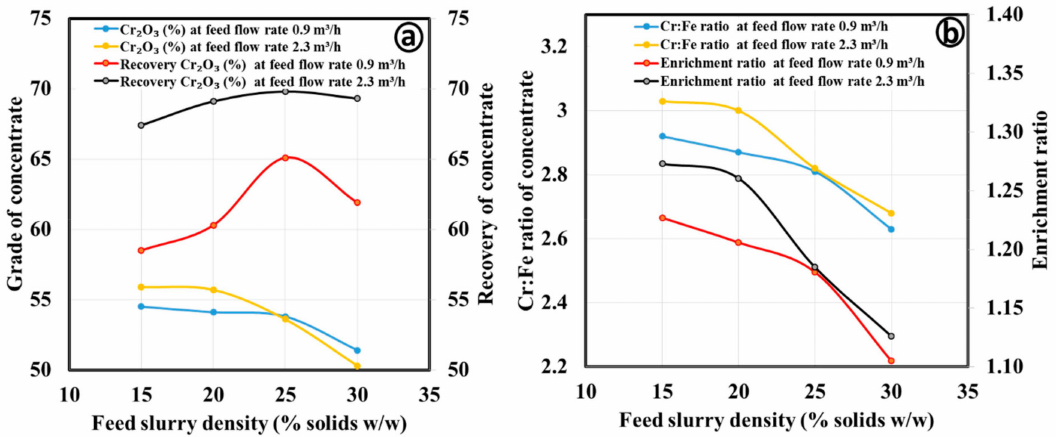
Figure 6. Influence of the feed flow rate and slurry density on the treatment of coarse concentrate by the spiral FM1 design ( a ) for grade and recovery; ( b ) for Cr:Fe ratio and enrichment ratio of concentrate.